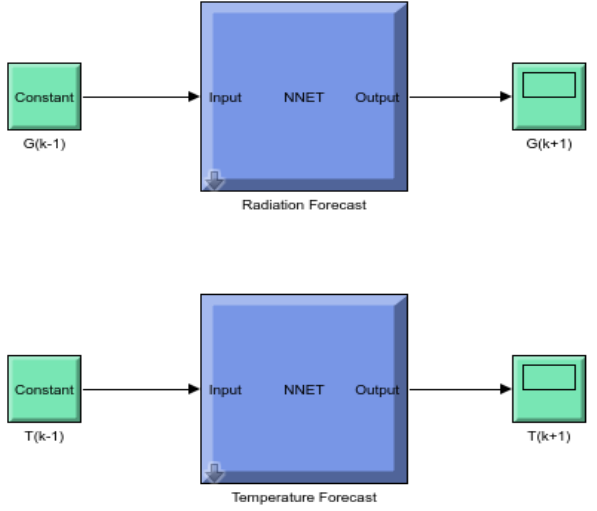
Figure 15. Simulink model of ANN forecasting.